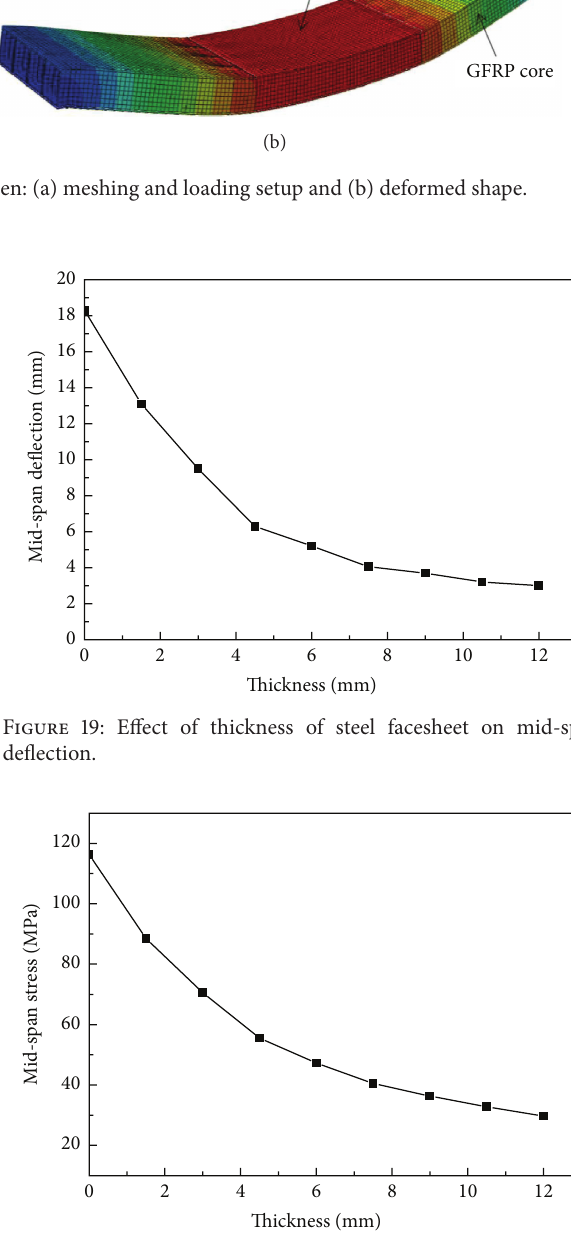
Figure 20: Effect of thickness of steel facesheet on mid-span stress.